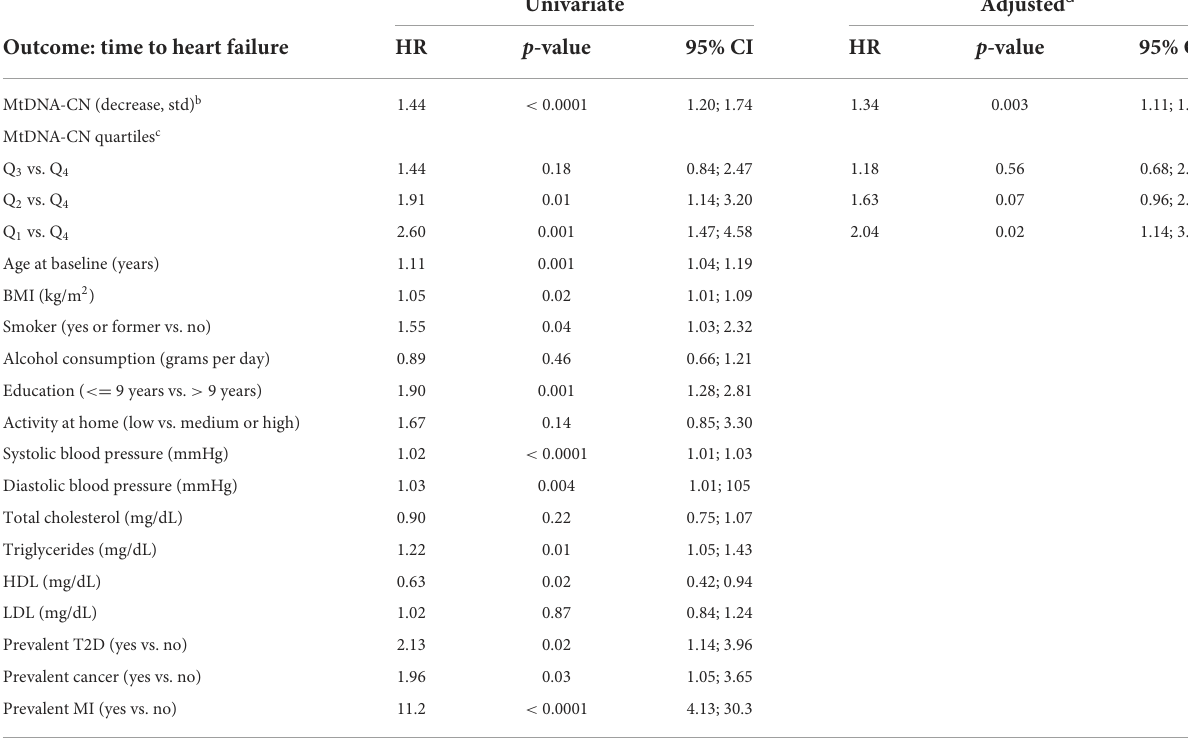
TABLE 3 Cox regression models examining effect of mtDNA-CN and other risk factors on risk for incident heart failure. Univariate